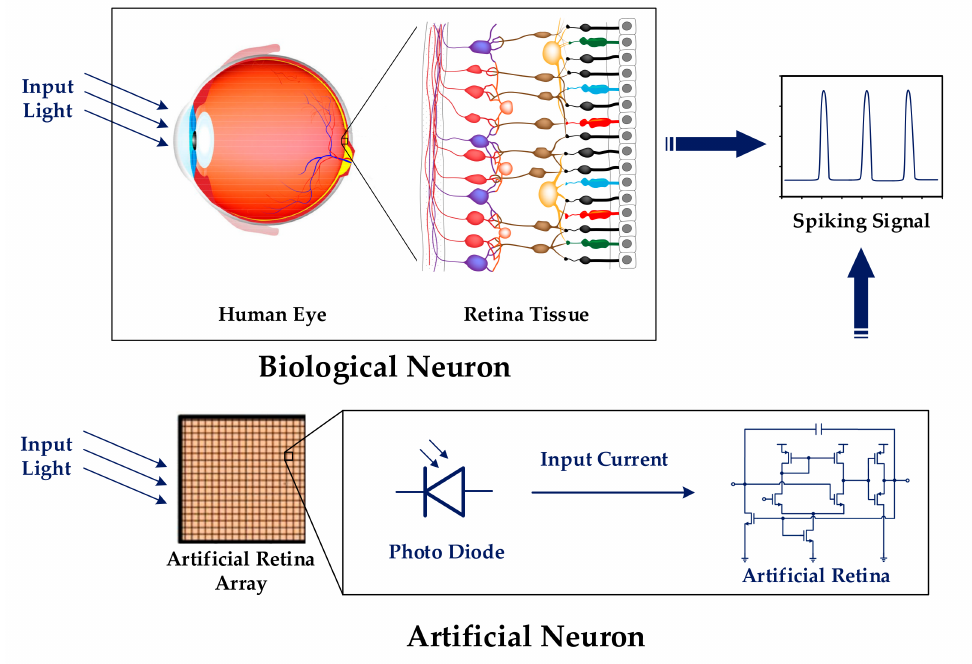
Figure 1. Schematic diagram of the working mechanism of the artificial neurons mimicking the biological